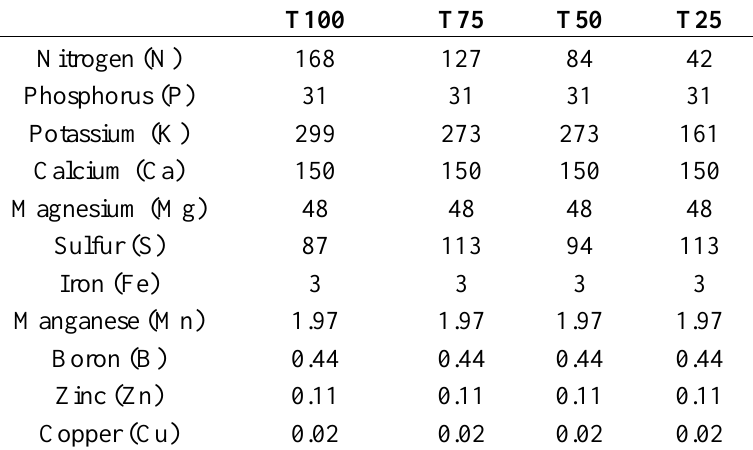
Table 1. Chemical composition (in mg·L −1 ) of nutrient solutions based on Steiner